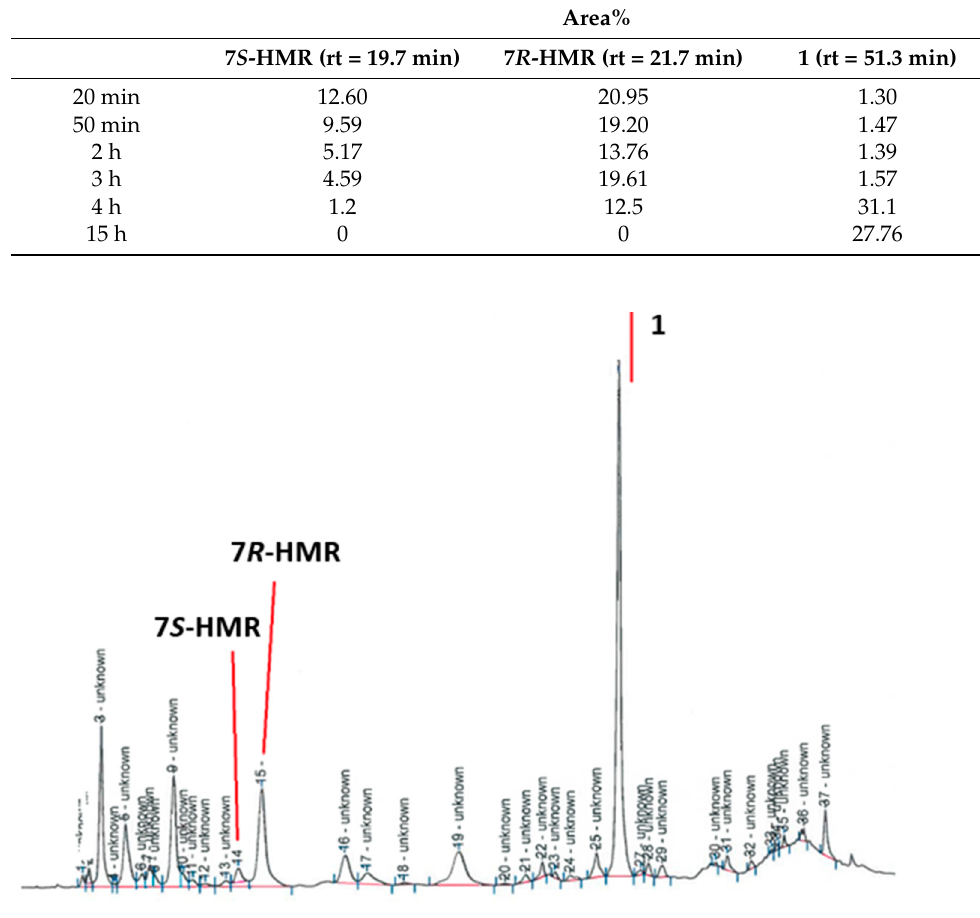
Figure 1 . HPLC chromatogram relative to the reaction after 3.5 h.